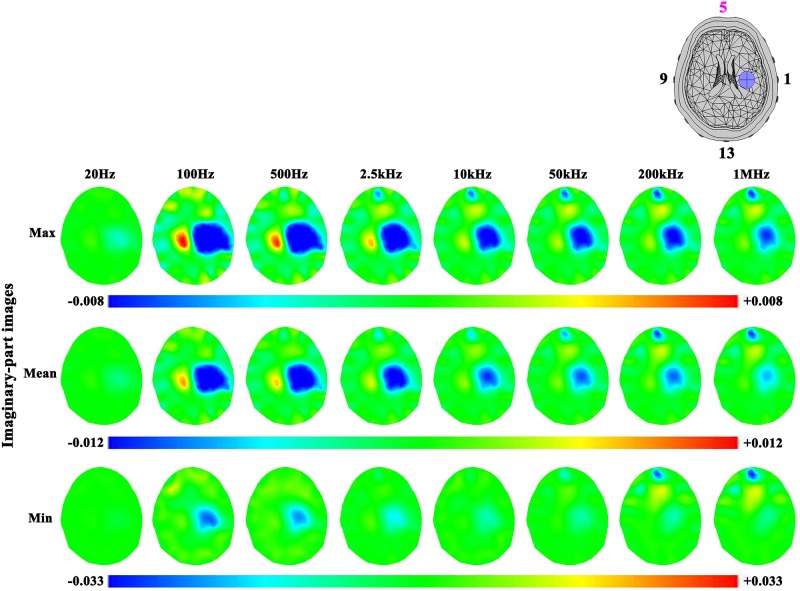
Imaginary-part images of the ischemic stroke lesion and the effects of three levels of contact impedance.